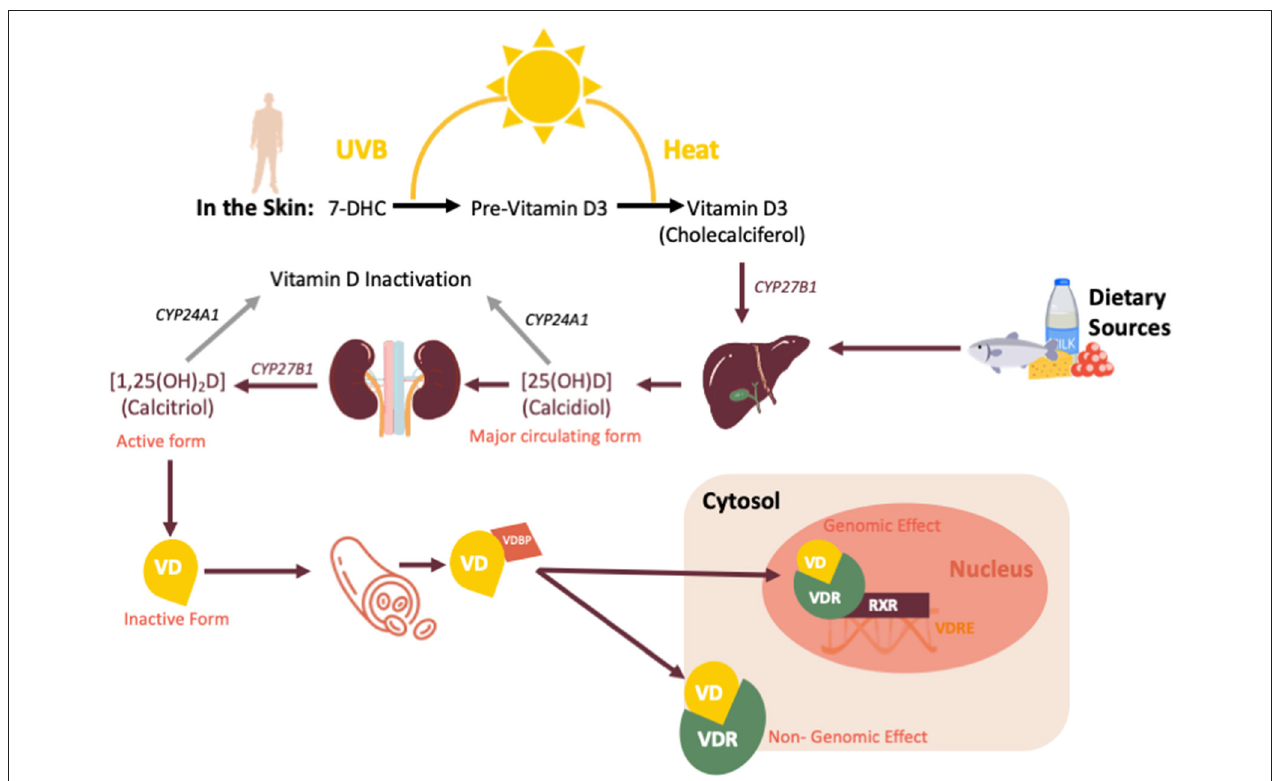
FIGURE 1 | Vitamin D sources, synthesis and metabolism. CYP27B1, cytochrome P450 Family 27 Subfamily B Member 1; CYP24A1, Cytochrome P450 Family 24 Subfamily A Member 1; VD, vitamin D; VDBP, vitamin D binding protein; VDR, vitamin D receptor; VDRE, vitamin D response element; RXR, retinoid-X receptor.